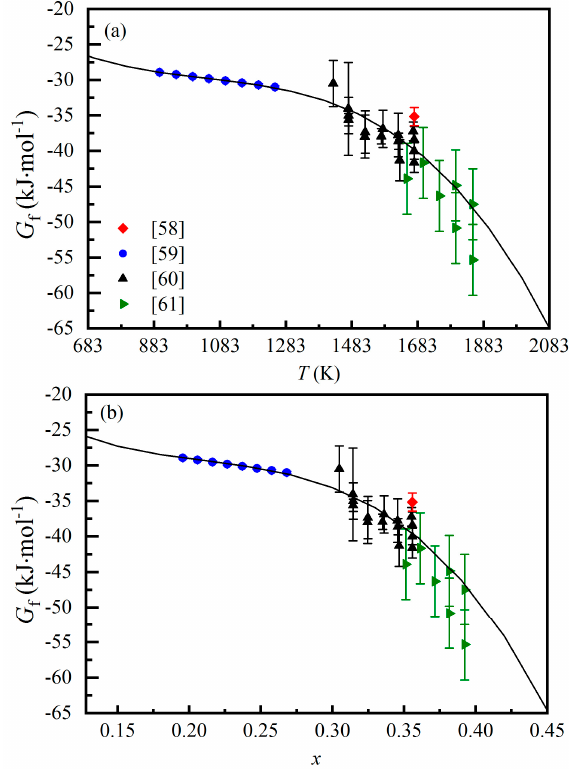
Figure 7. ( a ) Correlation between the G f and temperature ( T ) established with the experiment data